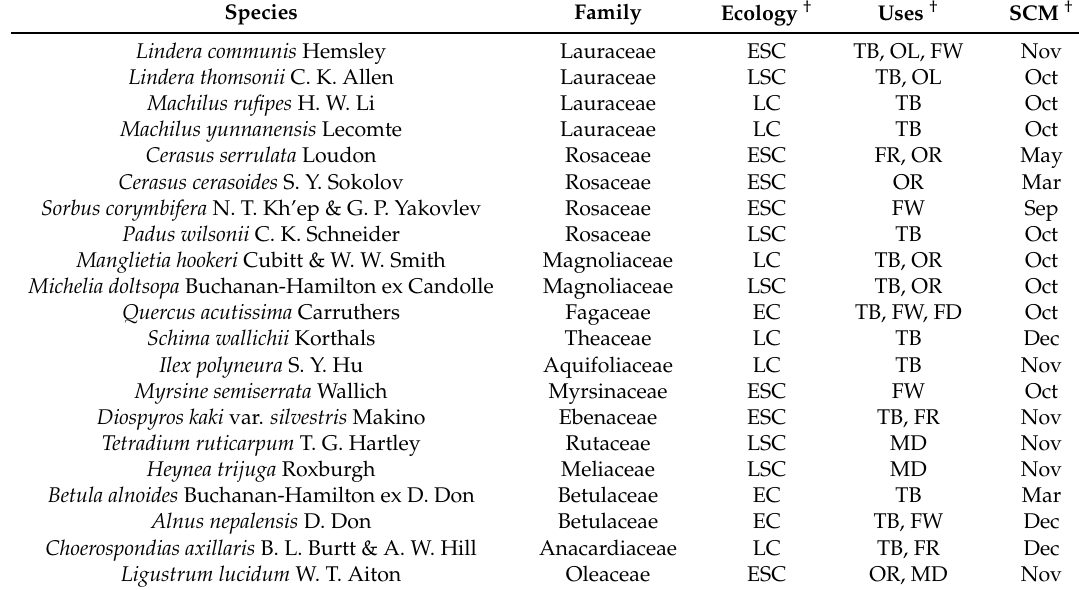
Table 1. The characteristics of 21 tree species native to the subtropical evergreen broad-leaved forests in SW